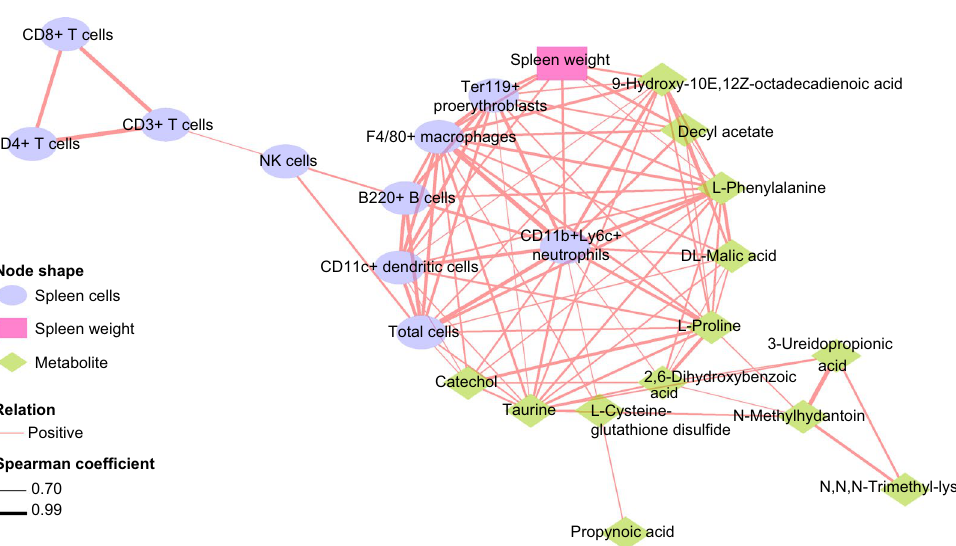
Figure 4. Associations among spleen cell types, spleen weight and the metabolites of plasma samples. ( A ): Heatmap of Spearman rank correlation coefficients between counts of splenic cell types or spleen weight and the metabolites of plasma samples. * P < 0.05 and FDR-corrected P > 0.05, # P (FDR-corrected) < 0.05, ## P (FDR- corrected) < 0.01, ### P (FDR-corrected) < 0.001, #### P (FDR-corrected) < 0.0001. ( B ): Correlation network analysis reveals the associations among counts of spleen cell types, spleen weight and the plasma metabolites. Each node shape represents spleen cell types, spleen weight or plasma metabolites, respectively. The pink lines connecting the nodes indicate positive correlation and the line weight indicates spearman correlation coefficient. We created the network using Cytoscape software 3.8.0.